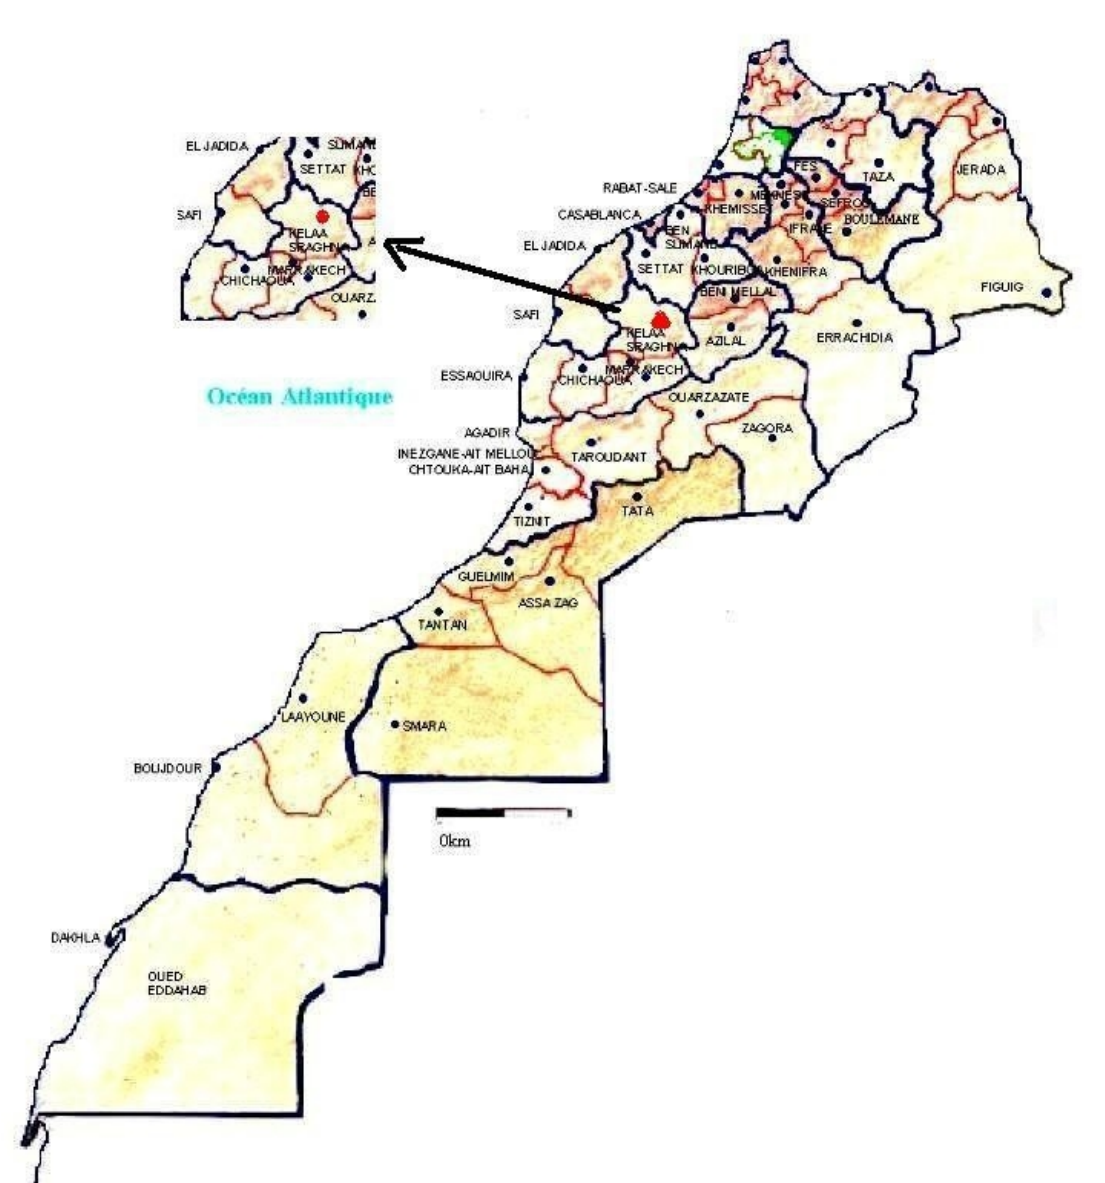
Figure 1. Geographical chart of Morocco indicating Marrakech Tensift Al Haouz region and the province EL Kelaa des